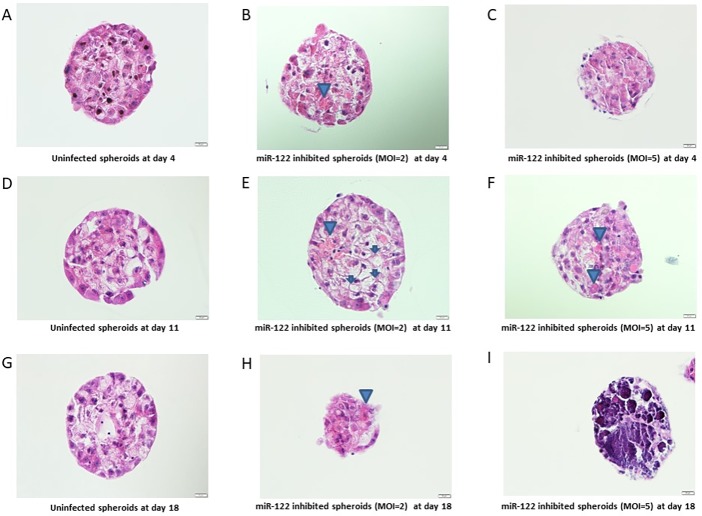
H&E staining of liver organoids.IHC sections of liver organoids stained with H&E at 4 days post-infection (A-C), 11 days post-infection (D-F), and 18 days post-infection (G-I). Left column pictures (A, D, G) show control organoids, middle column show miR-122 inhibited organoids with MOI = 2 (B, E, H), right column show miR-122 inhibited organoids with MOI = 5 (C, F, I). Arrows indicate ballooned hepatocytes, arrowhead indicate Mallory’s hyaline.